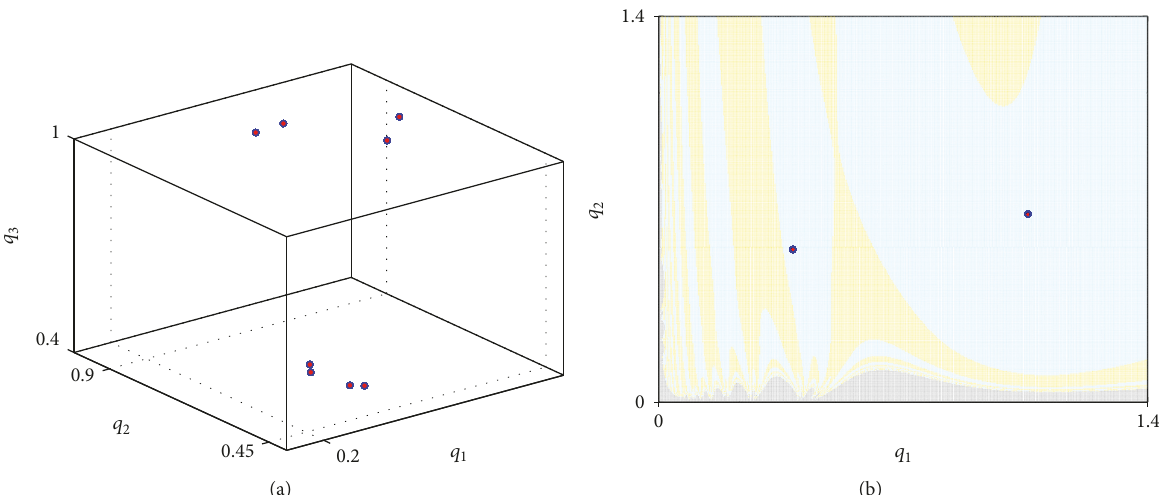
Figure 4: (a) Phase portrait for 8 cycles at 𝑘 1 = 8.75 , 𝑘 2 = 7 , 𝑘 3 = 8.1 , 𝑐 1 = 0.19 , 𝑐 2 = 0.18 , and 𝑐 3 = 0.17 . (b) Plane section of basin of attraction at 𝑘 1 = 8.5 , 𝑘 2 = 5 , 𝑘 3 = 7 , 𝑐 1 = 0.19 , 𝑐 2 = 0.18 , 𝑐 3 = 0.17 , and 𝑞 3 = 5.04 .